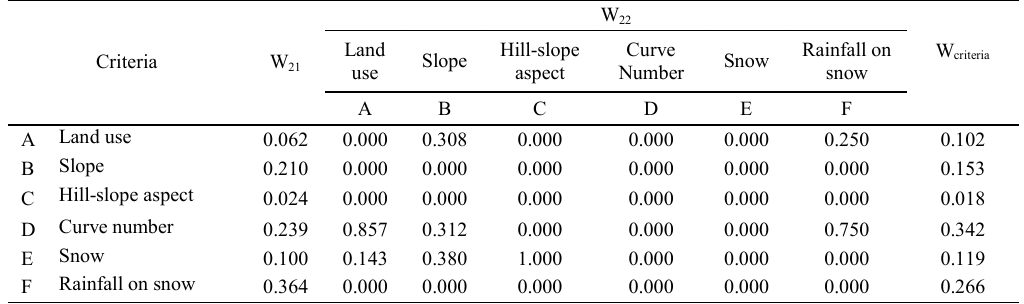
), the inner dependences matrix (W 21 (W